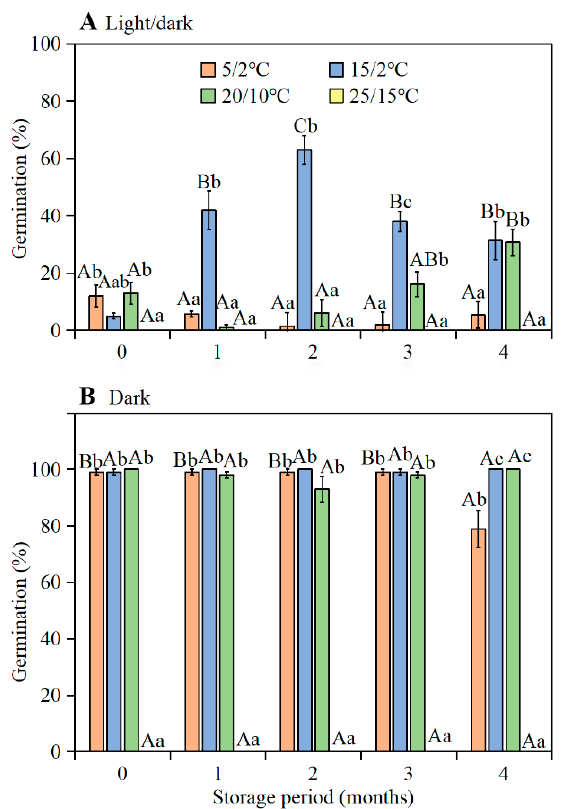
Figure 2. Final germination percentages (mean ± 1 s.e.) of a composite sample of seeds from flowers with long, intermediate, and short styles of Ixiolirion songaricum ( A ) in light and ( B ) in dark at four temperature regimes following 0-, 1-, 2-, 3-, and 4-months of dry storage at laboratory conditions. Bars with different uppercase letters (A, B, C) indicate significant differences among different storage times at the same temperature regimes and different lowercase letters (a, b, c) significant differences among different temperature regimes at the same storage time in the light or dark (Tukey’s HSD, p = 0.05).